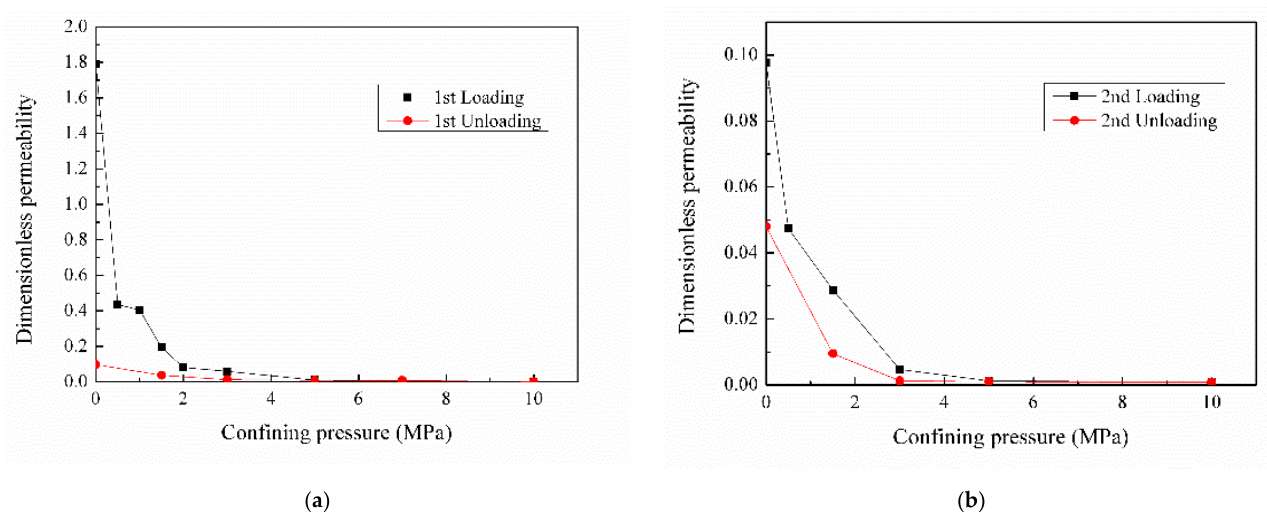
Figure 12. The digital core and streamlines of the first 0 MPa: ( a ) the digital core, ( b ) the streamlines.